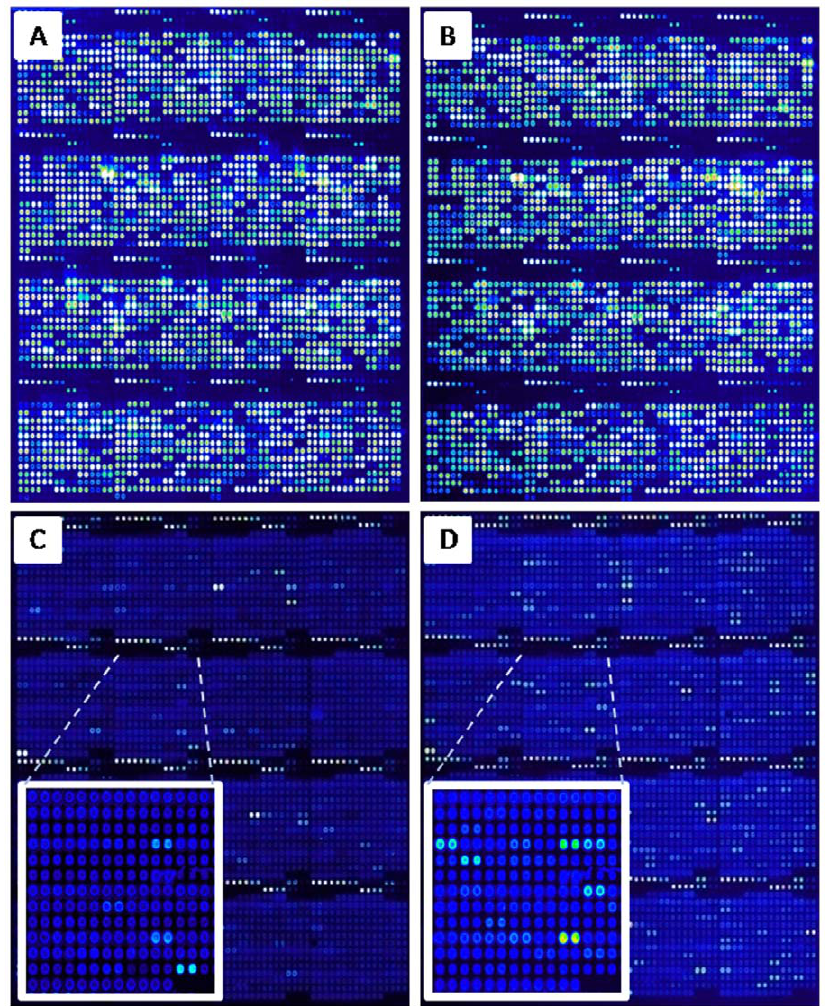
Figure 1. Construction of a B.henselae protein microarray. Arrays were printed containing 4032 spots from B. henselae proteins, as well as positive and negative control spots. Proteins were printed in duplicates and average signal intensities were calculated. Each array contains positive control spots printed from 6 serial dilutions of purified IgG, 6 serial dilutions of EBNA1 protein, and 6 ‘‘No DNA’’ negative control spots. The array was probed with anti-His antibody (A) or anti-HA antibody (B) as described in Materials and Methods, to confirm the expression and printing of 1433 B. henselae ORFs. (C and D) Comparison of arrays probed with naı¨ve serum and positive serum. The arrays were read in a laser confocal scanner, analyzed, and the data normalized as described in Materials and Methods. The signal intensity for each antigen is represented by a rainbow palette of blue, green, red and white, corresponding to increasing signal.